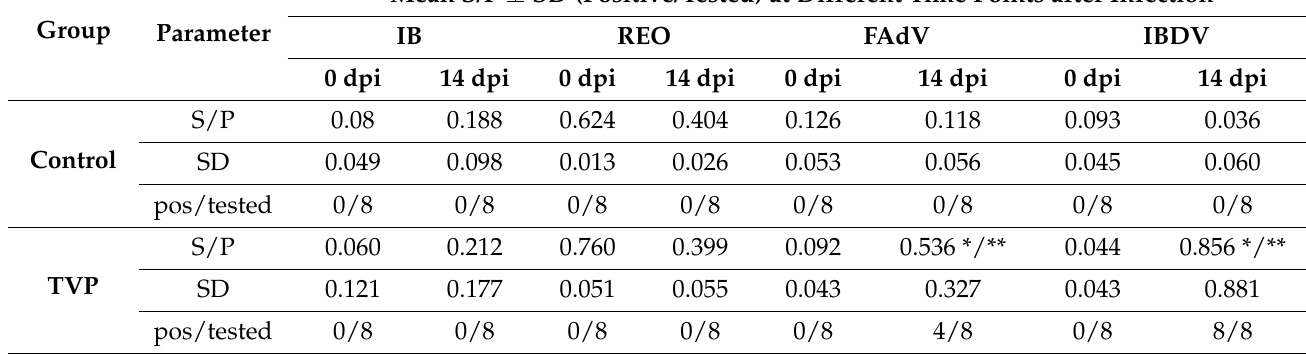
Table 4. Mean IB, reoviruses (REO), picornaviruses, fowl adenoviruses (FAdV) and infectious bursal disease viruses (IBDV) antibody levels ± SD in Control and TVP group at different dpi. In birds of the TVP-infected group, a strong seroconversion against IBDV and FAdV was recorded at 14 dpi.